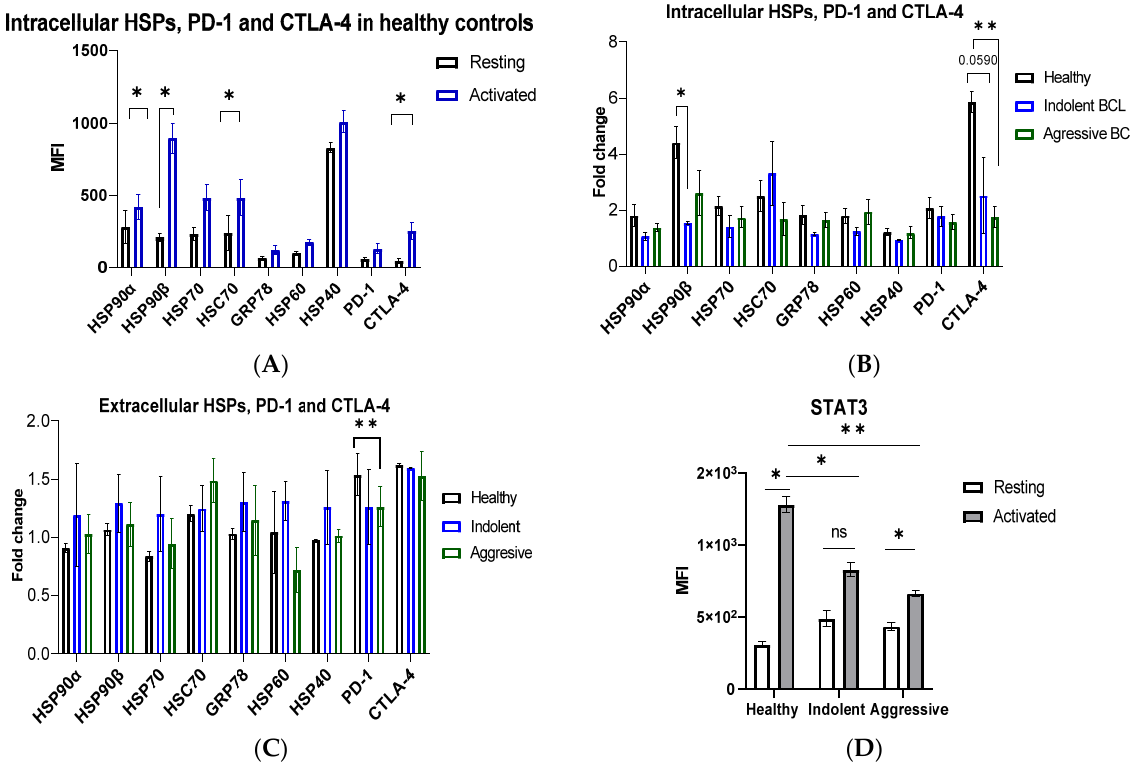
Figure 1. HSP, PD-1, CTLA-4, and STAT3 expression in activated T cells. ( A ) Intracellular expression of HSPs, PD-1, and CTLA-4 (as mean fluorescence intensity, MFI) in activated T cells in healthy controls. Pan T cells were isolated from healthy PBMCs and stimulated with anti-CD3/CD28 or unstimulated (resting) for 48 h. ( B ) Intracellular HSPs, PD-1, and CTLA-4 in indolent and aggressive lymphoma patients. ( C ) Extracellular HSPs, PD-1, and CTLA-4 in indolent and aggressive lymphoma patients. The fold change in MFI was calculated by normalizing the activated to the resting T cells. ( D ) STAT3 expression in resting and activated T cells in healthy controls and lymphoma patients. Data represents mean ± SEM. ns, not significant, * p < 0.05, ** p <